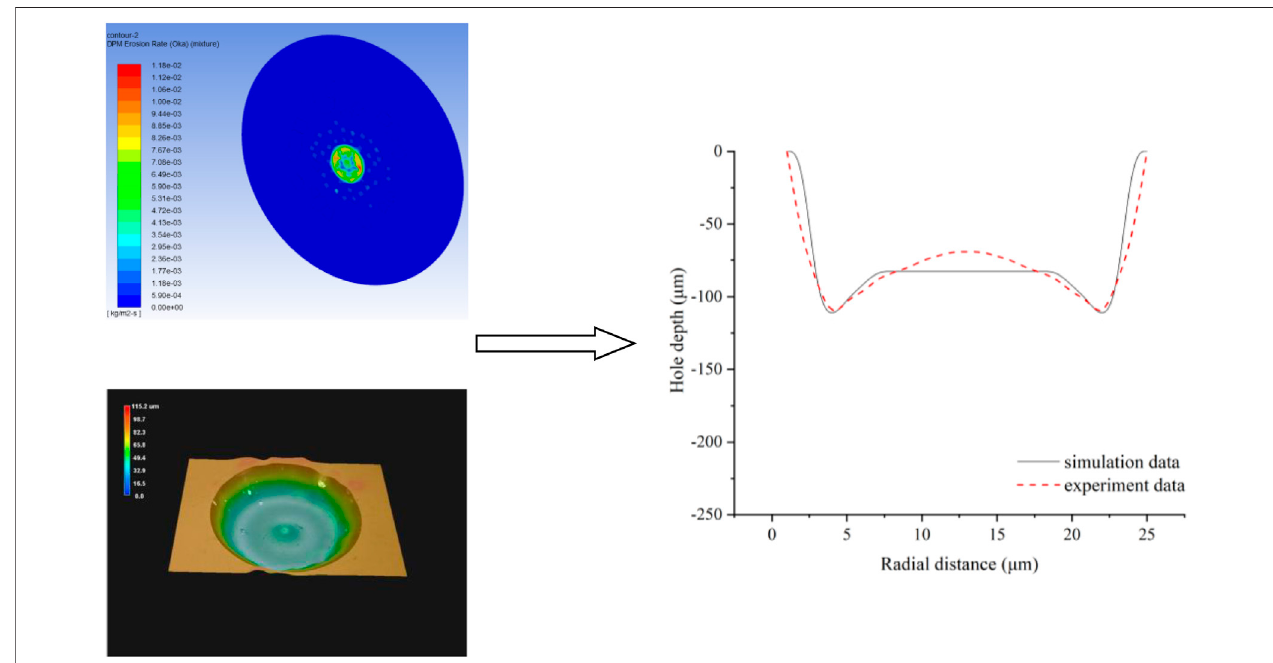
FIGURE13| Two-dimensionalcross-sectionsofthesimulationdataandtheexperimentaldataundertheexperimentalconditionsof8 MPaand60 swithvibration.